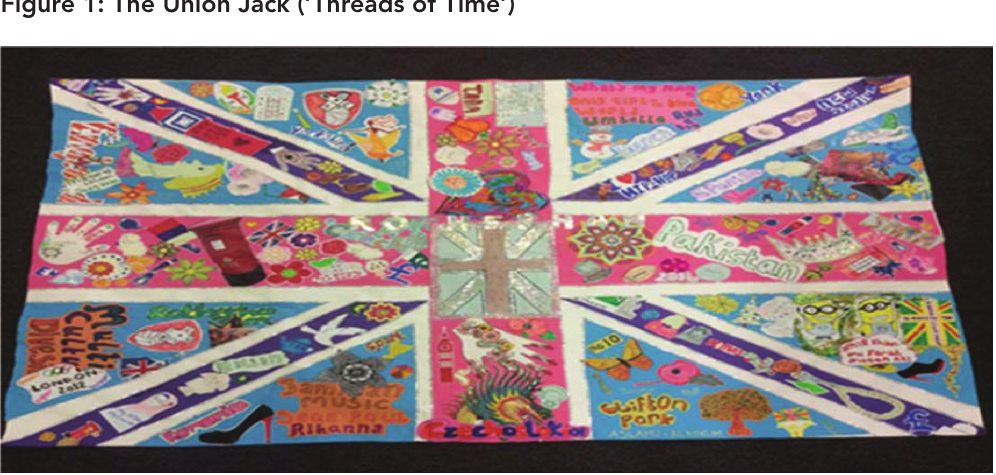
Figure 1: The Union Jack (‘Threads of Time’)